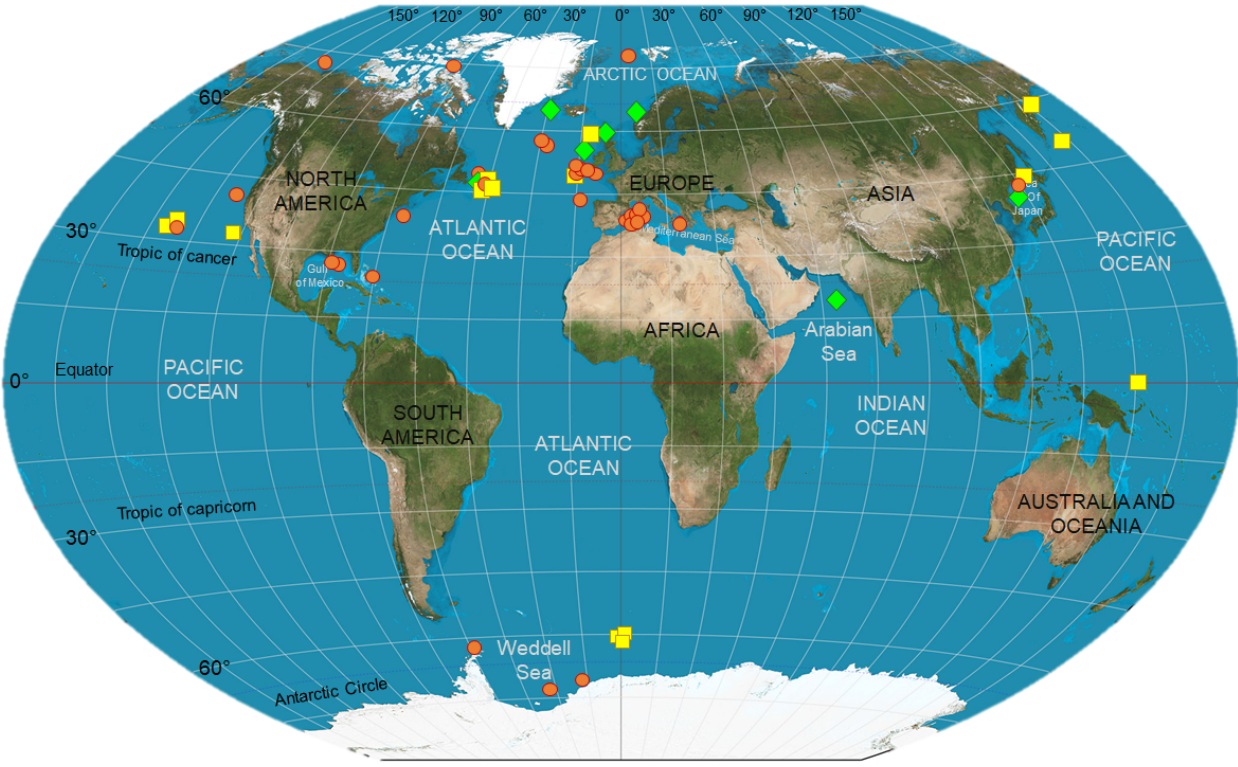
Figure 1. Deep-sea biomarker studies in the world ocean. Symbols indicate where the studies listed in Table 2 have been carried out. In detail, red circles represent those investigations that have used stable isotopes as food-web tracers; whereas yellow squares and green diamonds indicate those which used lipids and a combination of SIA and FA analysis, respectively. This map is a derivative of “Creative Commons The world on Winkel tripel projection” by Strebe (2011), used under CC-BY-SA